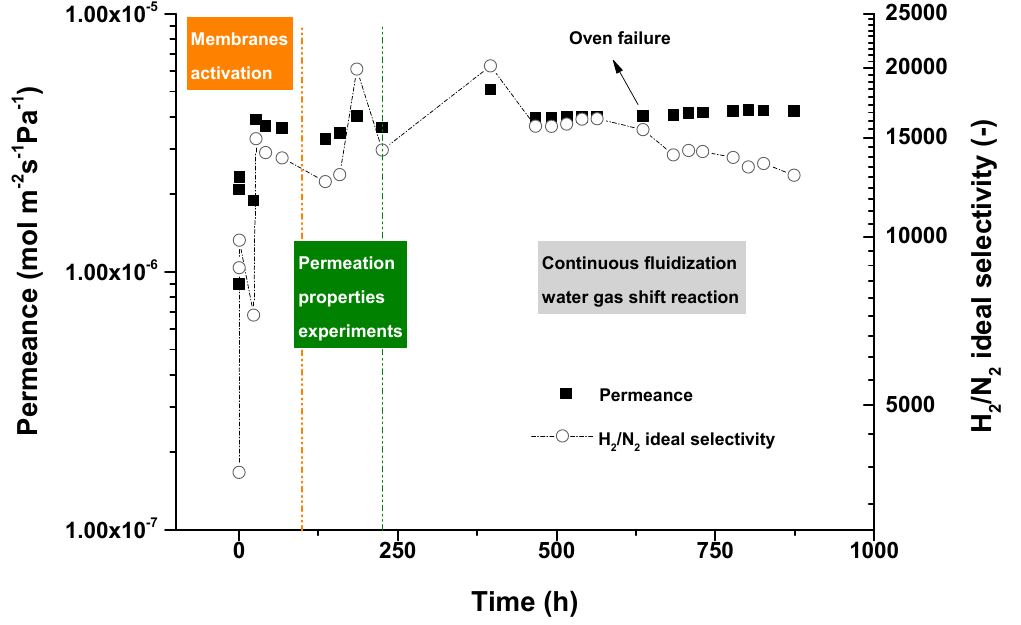
Figure 2. Long-term performance of a fluidized-bed membrane module during 900 h of continuous operation at high-temperature WGS conditions. Reprinted from [86] with permission from MDPI.